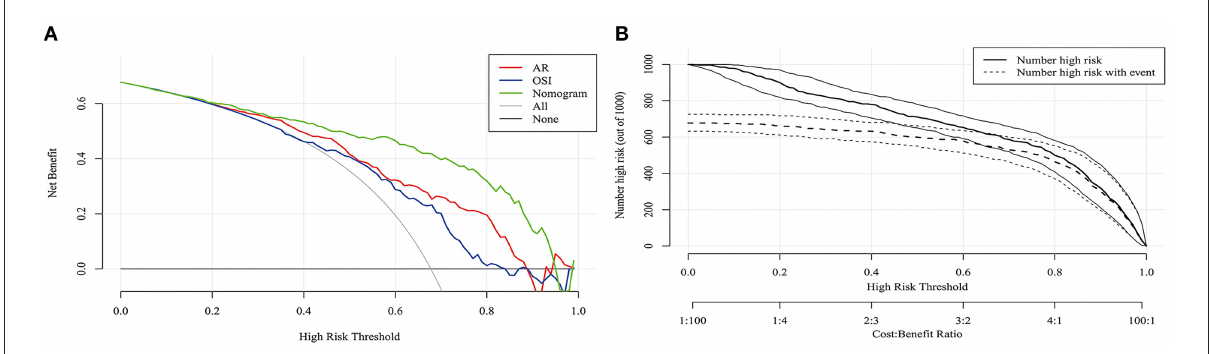
FIGURE4 DCA and CIC curves of nomogram in the training cohort. (A) DCA curve. (B) CIC curve. DCA, decision curve analysis; CIC, clinical impact curve.